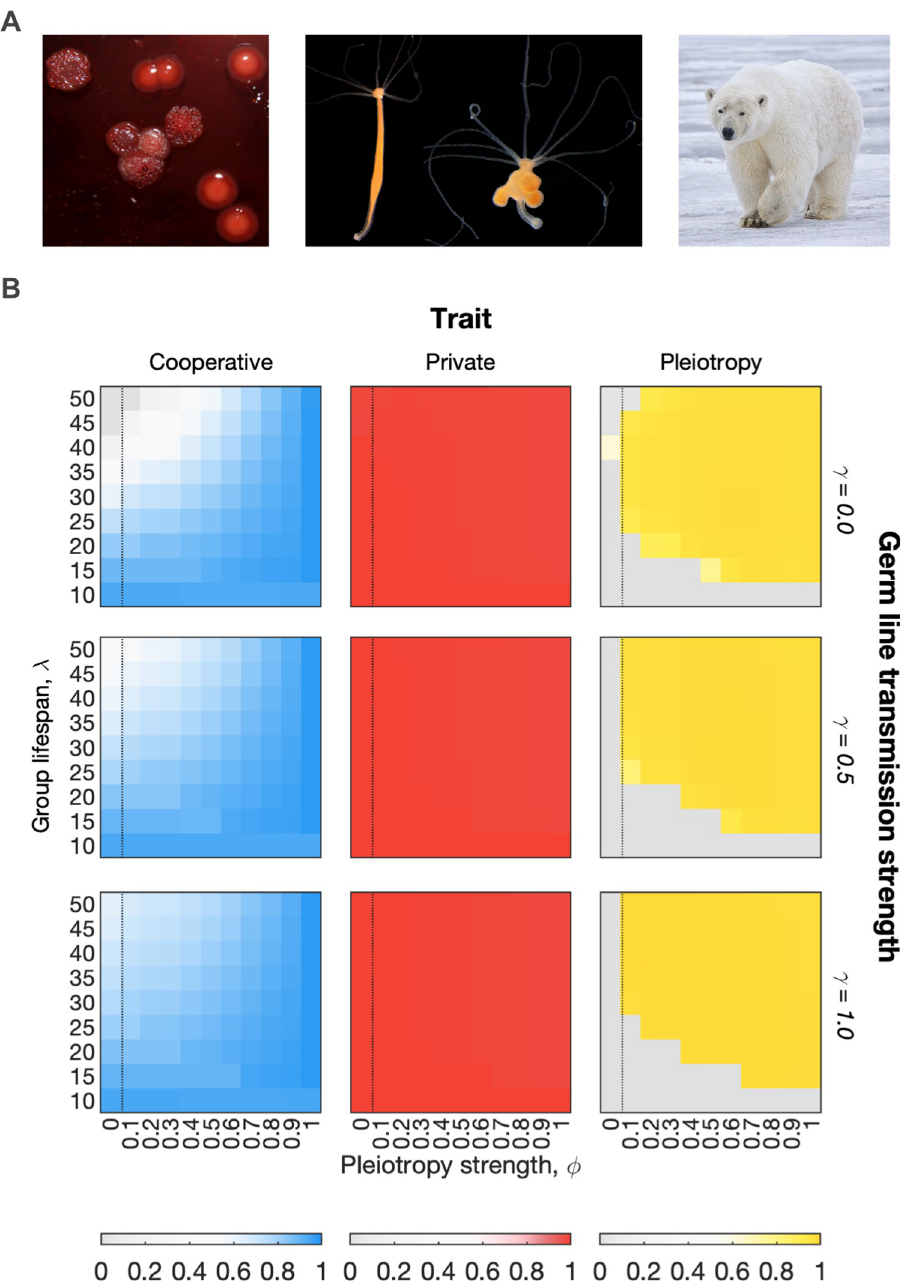
Fig 6. The evolution of pleiotropy in multicellular groups with a germ line. (A) Cheater lineages that threaten cooperation evolve in multicellular species with a germ line, as well as in simpler multicellular groups. In multicellular organisms, these lineages manifest themselves as tumours and cancers that emerge by mutation. From left to right, bacteria, simple and complex animals. Bacteria: Spontaneous lasR mutant emerge during evolution of the pathogen Pseudomonas aeruginosa . The mutants do not contribute to the production of public goods molecules that their wild- type counterparts do, which enables them to gain a short-term competitive advantage ( Image credit : Sheyda Azimi and Steve Diggle ). Simple animal: Spontaneous tumour formation in the basal metazoan Hydra, a tumour-bearing Hydra oligactis polyp (right) is shown next to a healthy animal (left). Credit : Alexander Klimovich , Kiel University . Complex animal: Cancer is widespread in long-lived animals, especially zoo animals where other selection pressures are minimised. Nanuq, a 29-year-old polar bear, died from liver cancer in The Columbus Zoo, Ohio, in 2017 (image shows a different polar bear; credit : Alan D . Wilson ). (B) To study the impact of pleiotropy on multicellular groups with a germ line, we varied γ , a measure of the strength of the transmission of the germline, modelled as the likelihood that